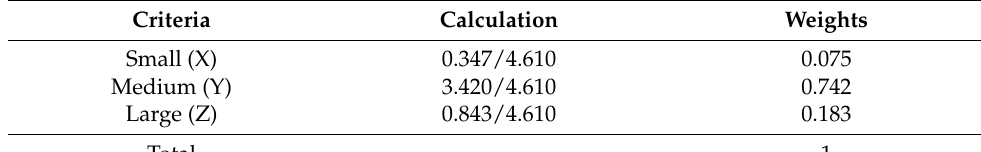
Table 17. The weights matrix—A6.